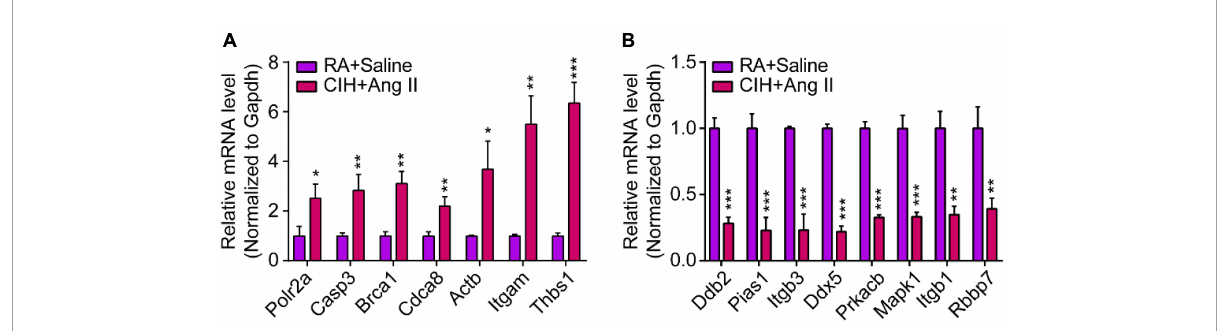
FIGURE6 Quantitative real-time polymerase chain reaction (qRT-PCR) analysis of gene expression levels of hub genes in aortic dissection (AD) tissues induced by chronic intermittent hypoxia (CIH) and Ang II. (A,B) qRT-PCR analysis show relative gene expression of hub genes, including (A) upregulated hub genes and (B) downregulated hub genes. n = 3 per group, * P < 0.05, ** P < 0.01, *** P <